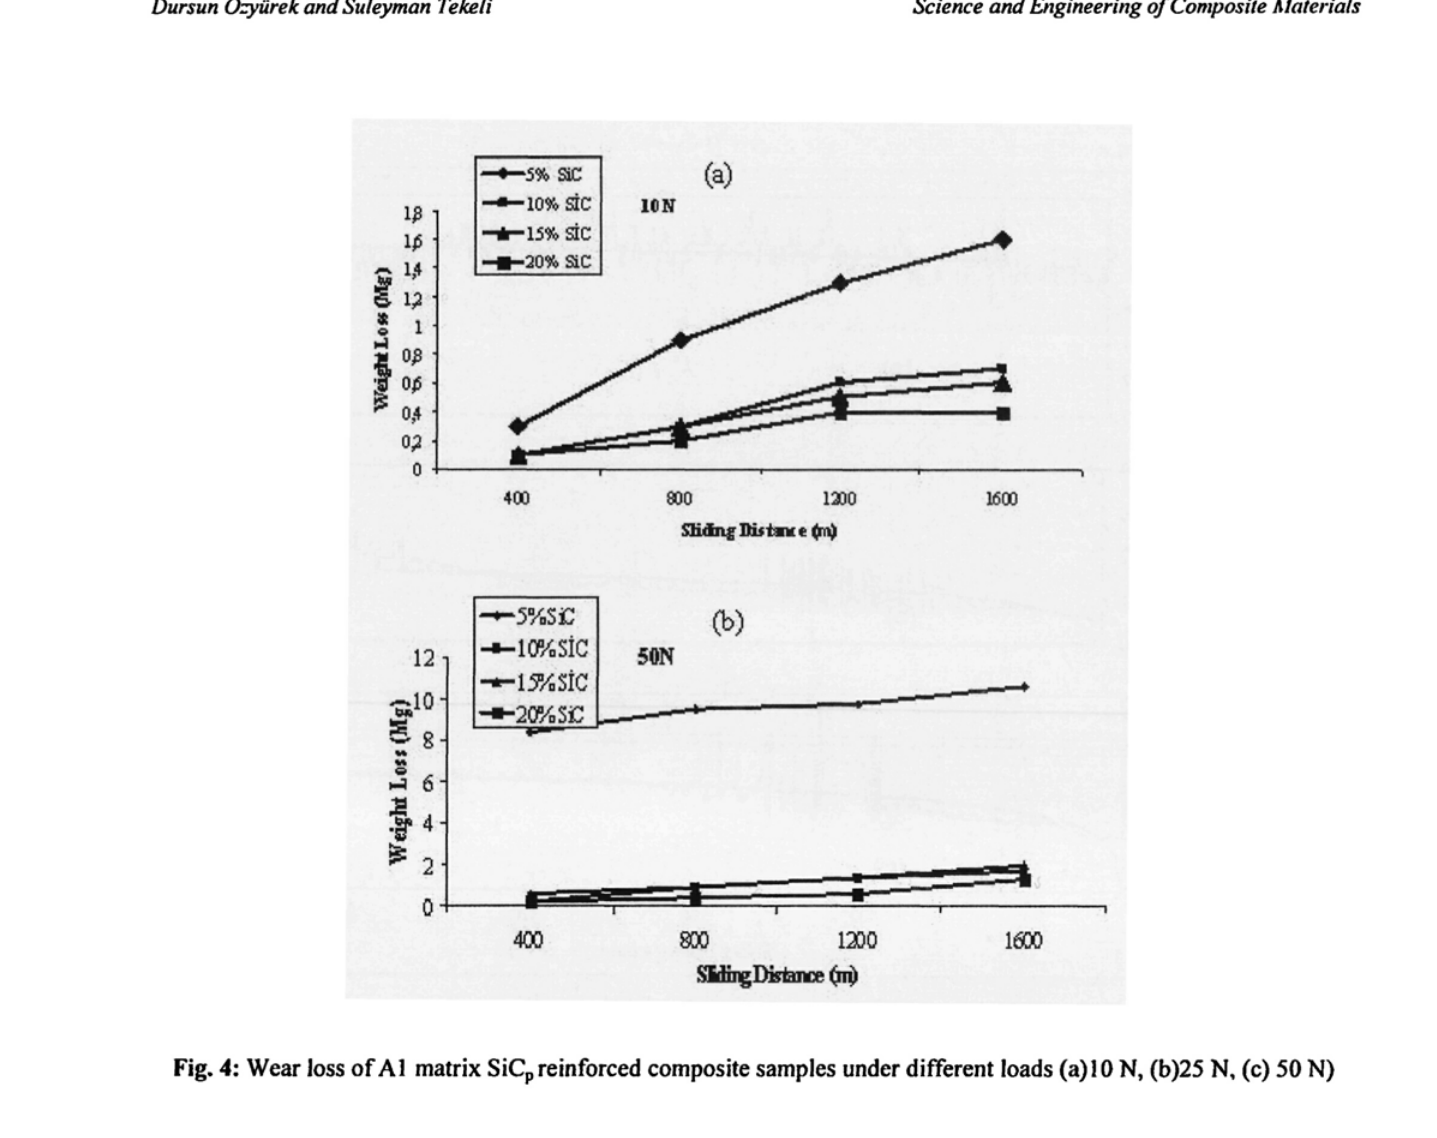
While friction coefficients change according to the applied load and SiC determined that these values do not depict a regular variety depending on the wear distance. The friction coefficients of the 10% and 20% SiC reinforced composite materials tested under different loads are given Figure 5. p While the friction coefficient of the sample with 10% SiC reinforcement and ION load is measured as 0.08